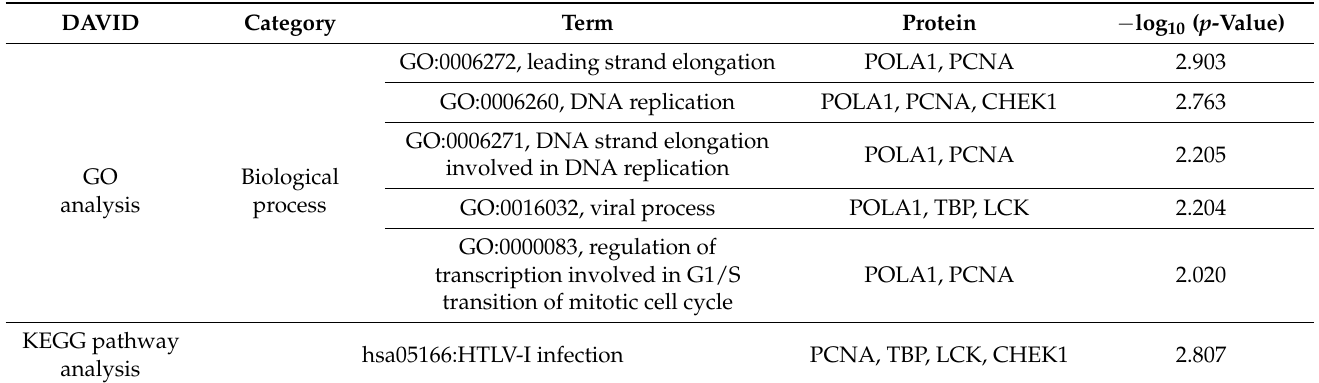
Table 2. GO terms and KEGG pathways of hub proteins ( ≥ 5 edges) down-regulated (>2-fold) in HeLa cells treated with H-CM compared with N-CM ( p <